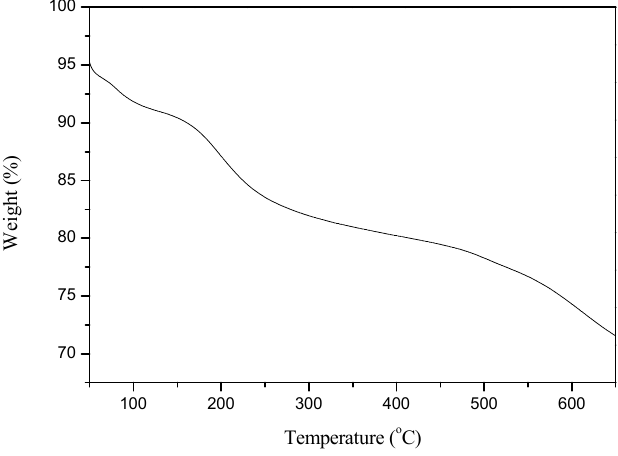
Figure 4. Thermal behavior of the bamboo-derived magnetic solid acid (pretreated by 0.25% H 2 SO 4 ).